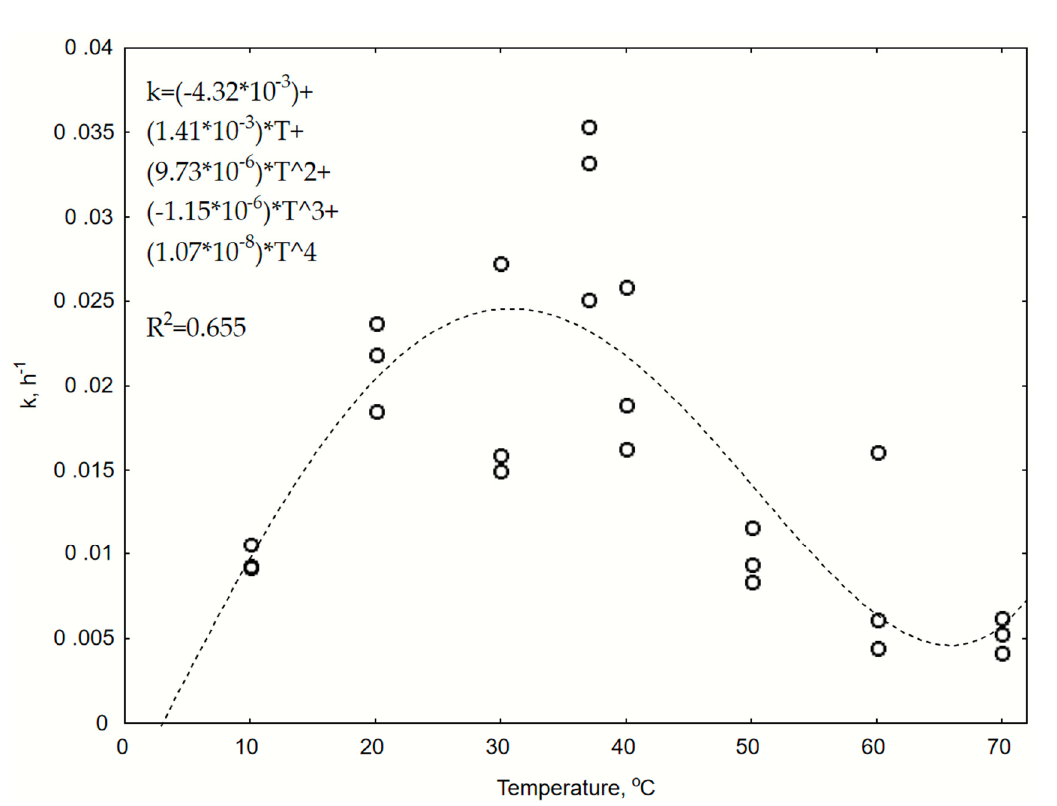
Figure 3. The influence of the composting temperature ( T ) on CO production constant rate ( k ). The CO potential production ( P CO ) as a function of ( T ) was described by Gompertz’s model [51] (Equation (4)) and illustrated in Figure 4.